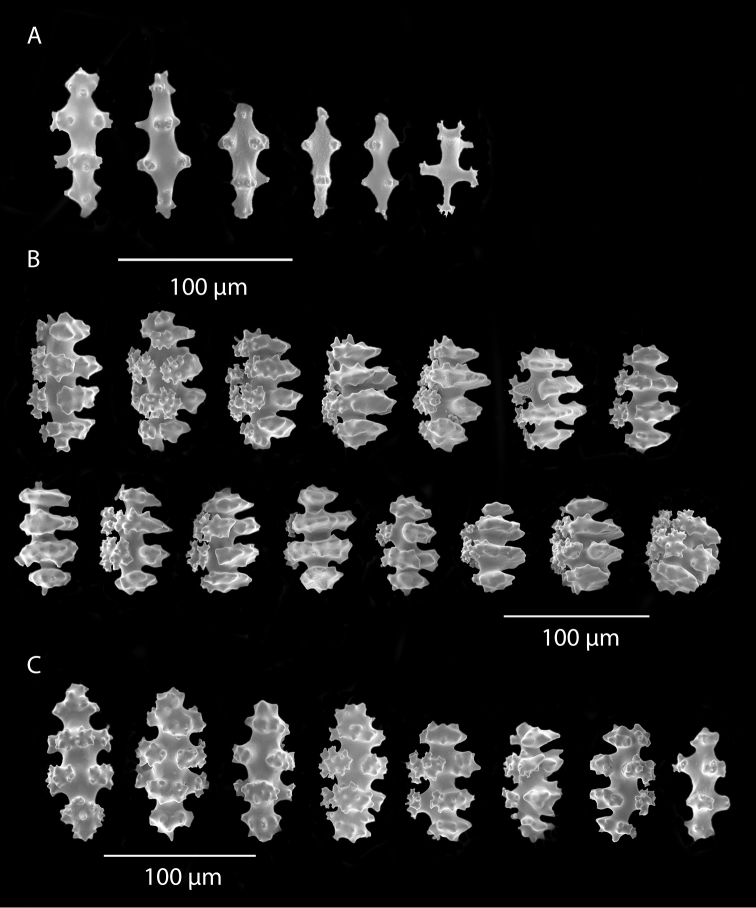
Eugorgialjubenkovia sp. nov., SBMNH 472232, SEM image. Sclerite color is white, but may give colony a very, very pale pink cast when in tissue. A Anthocodial sclerites B Double-discs (teeth evident in most) C Coenenchymal spindles.